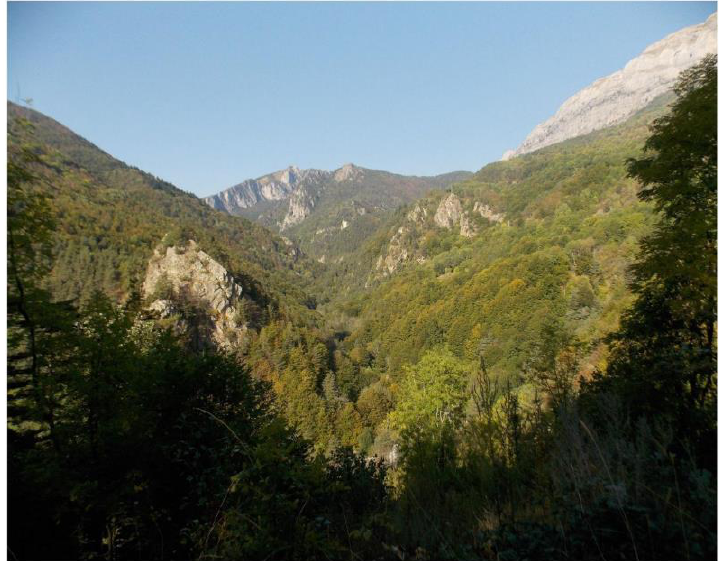
Figure 4. Picture of the upper portion of Negrone Valley, just beyond site 1.